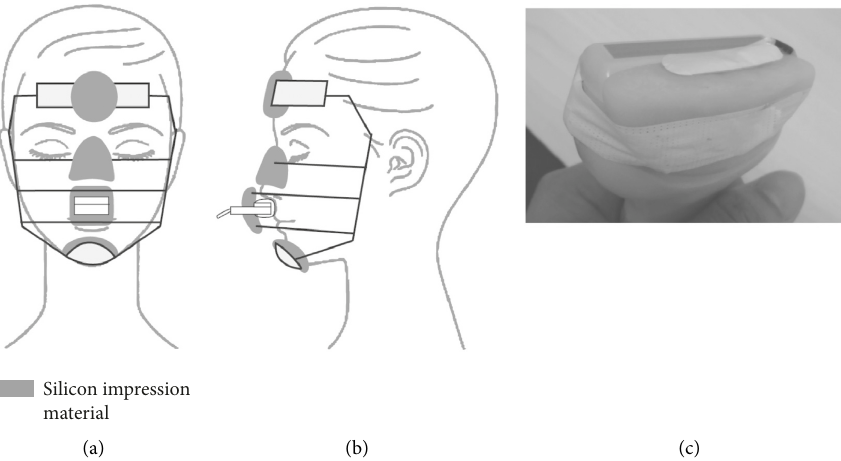
Figure 1: (a, b) A facemask was used for the measurement of the superior orbicularis oris muscle. Silicone impression material was placed onto a headrest, a chin cup, and an upper bow positioned above the root of the nose and fitted to the face in order to ensure accurate repositioning to the same position. (c) A pressure sensor was attached to a mounting base and fixed with adhesive tape.